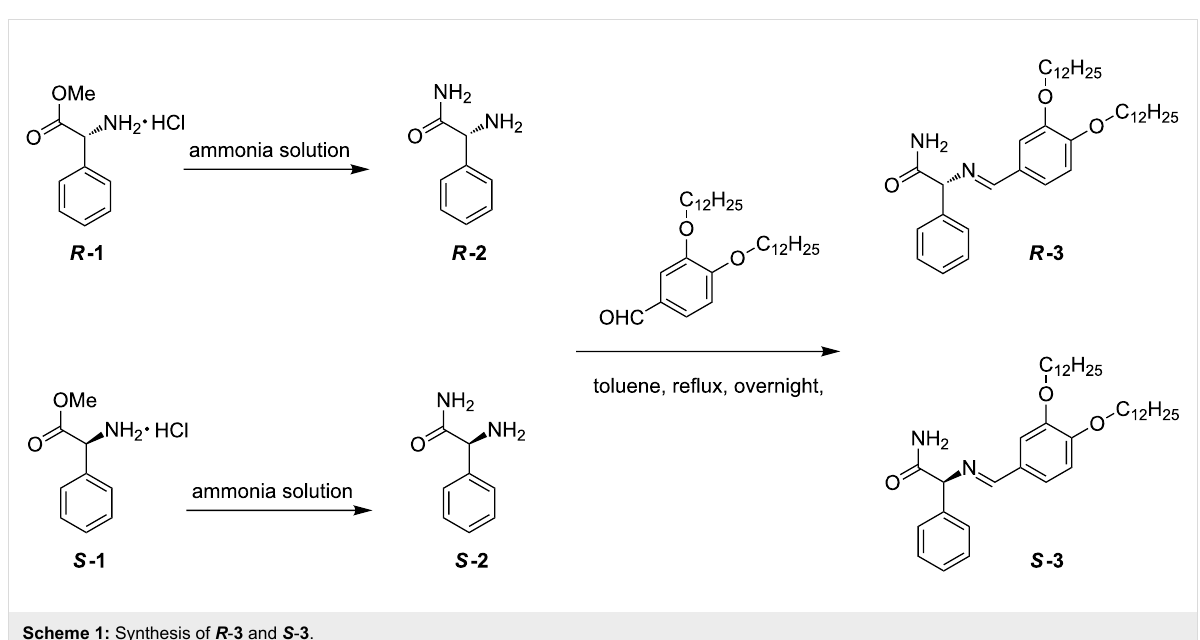
Scheme 1: Synthesis of R - 3 and S - 3 .